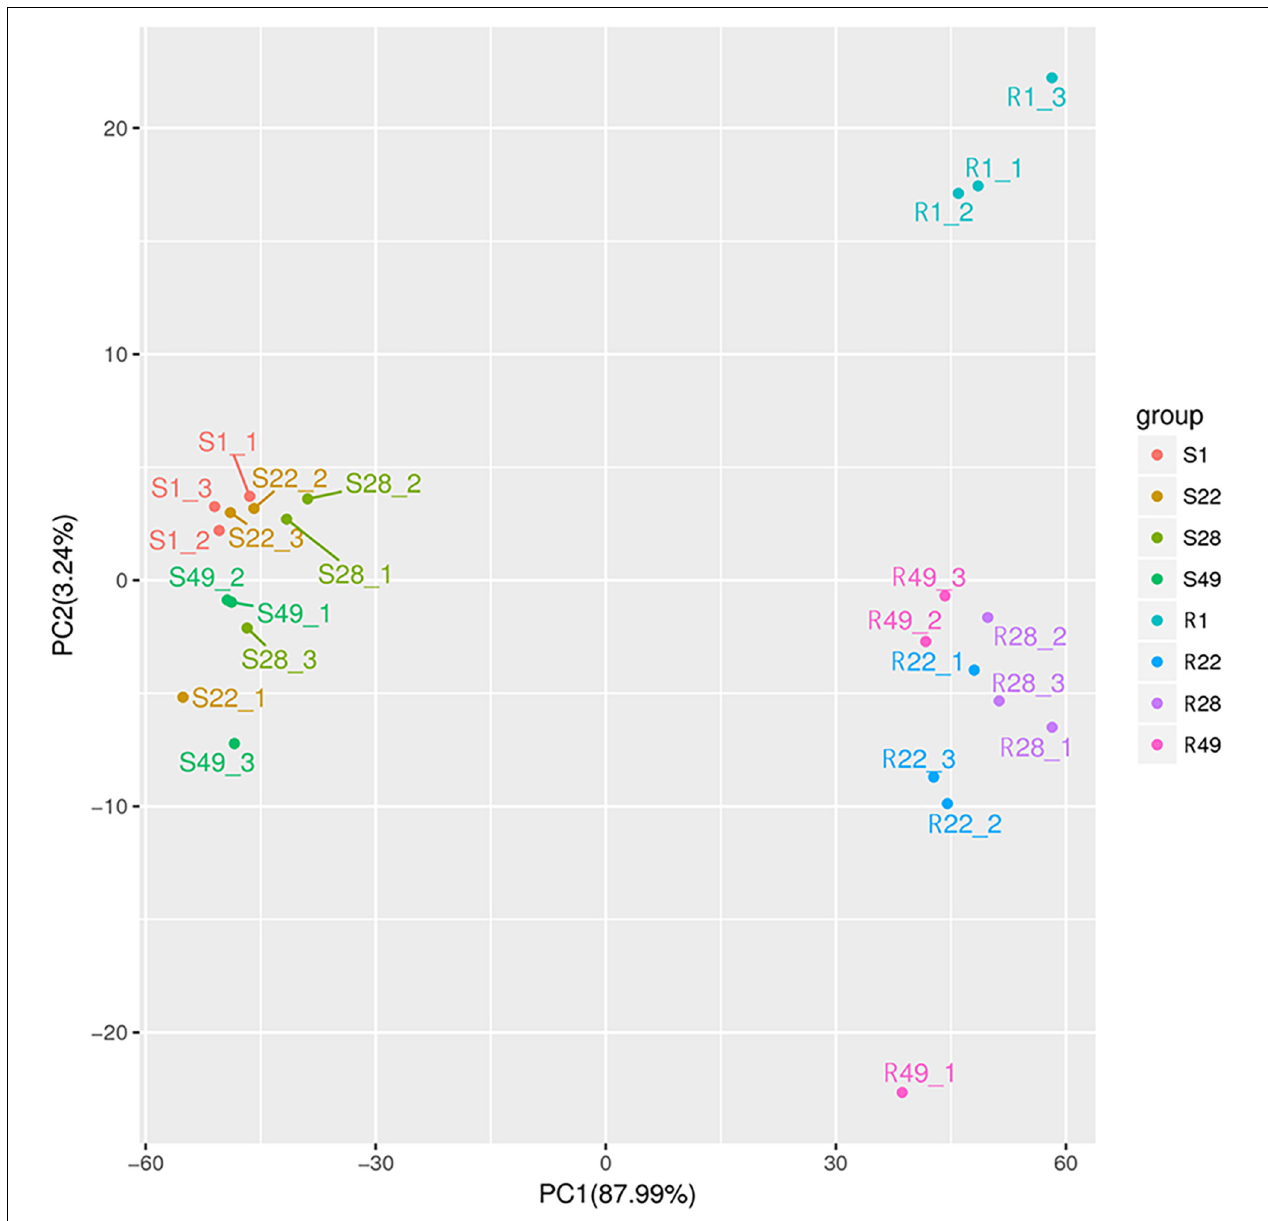
FIGURE 1 | Principal component analysis of tomato shoot (S1, S22, S28, and S49) and root (R1, R22, R28, and R49). 1, Control; 22, Ri + Pf + Th; 28, Fo; 49, Ri + Pf + Th +